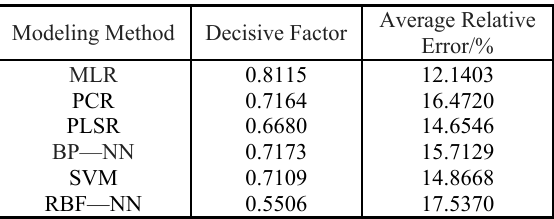
Figure 5. Estimated result of PCR